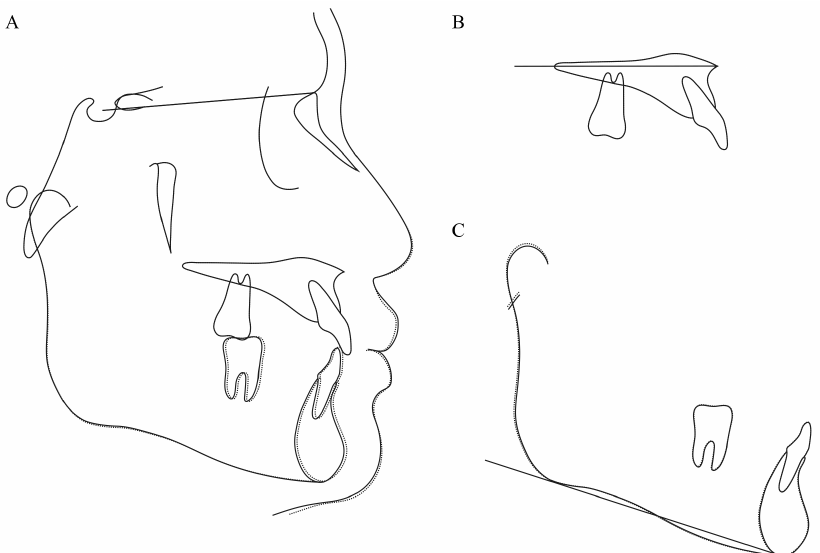
Figure 12. Superimposition at termination of active treatment and at completion of eruption of the maxillary left third molar. ( A ) On the SN plane at S. ( B ) On the palatal plane at ANS. ( C ) On the mandibular plane at Me. At termination of active treatment (17 years 9 months) (solid line); at completion of eruption of the maxillary left third molar (21 years 3 months) (dashed